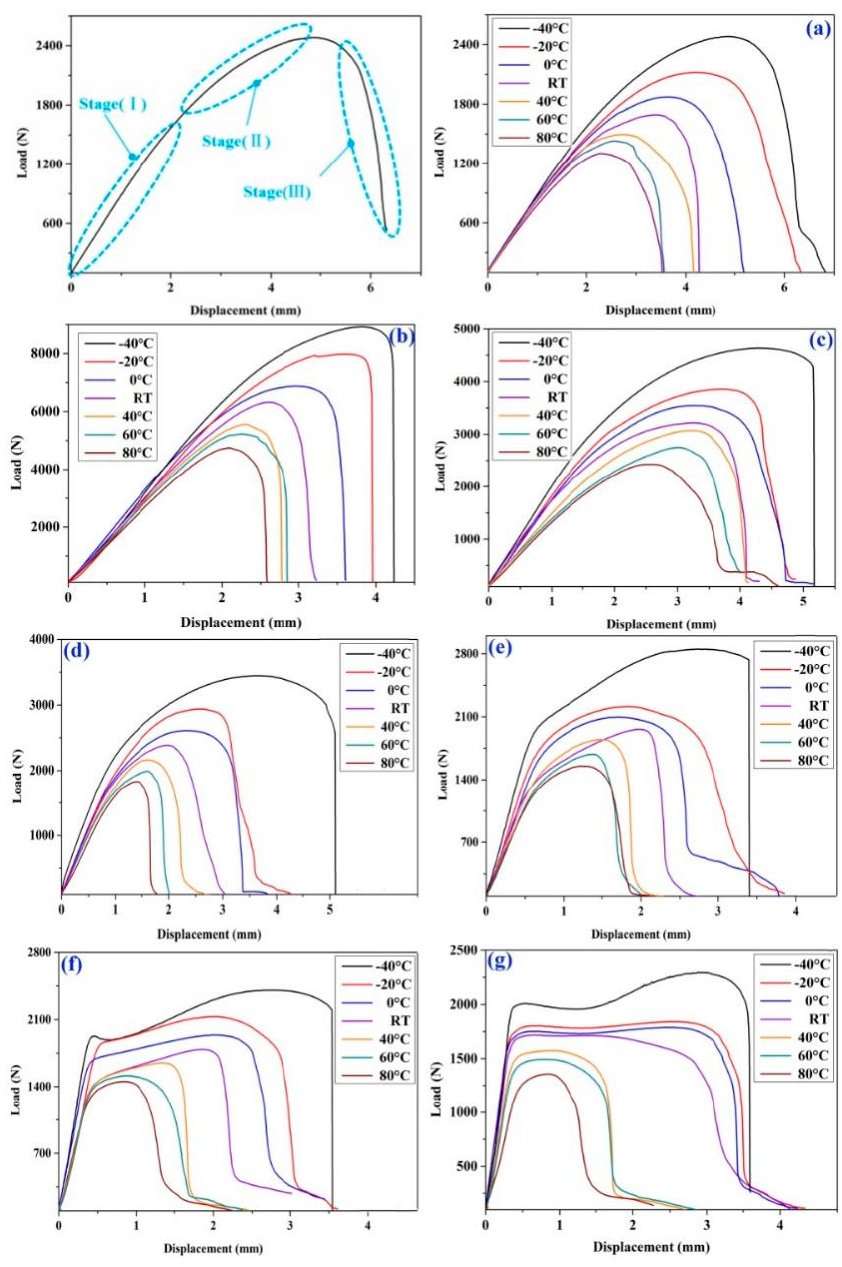
Figure 12. Load-displacement curves: ( a ) SLJ; ( b ) 15 ◦ SJ; ( c ) 30 ◦ SJ; ( d ) 45 ◦ SJ; ( e ) 60 ◦ SJ; ( f ) 75 ◦ SJ; ( g ) BJ.